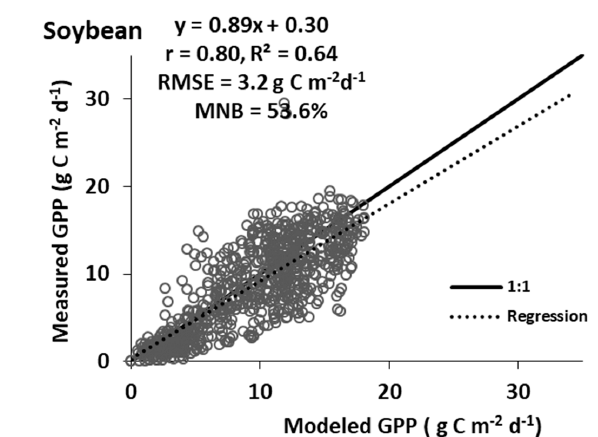
Figure 3. The relationship between AmeriFlux measured and LUEc modeled GPP for ( a ) all validation data with slope confidence interval ± 0.02 (n = 2130), ( b ) all maize validation data with slope confidence interval ± 0.02 (n = 1379), and ( c ) all soybean validation data with slope confidence interval ± 0.05 (n = 751).